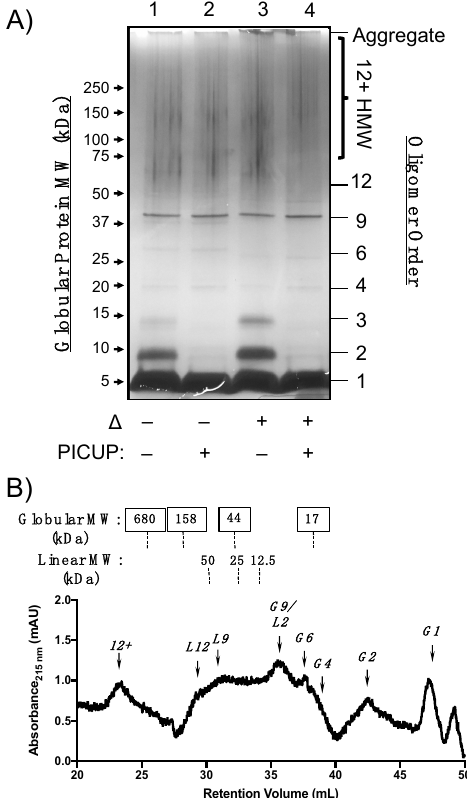
Figure 3. Structural characterization of A β (M1–40) oligomer quaternary structure. ( A ) Silver-stained SDS-PAGE gel of A β (M1–40) oligomers after 24 h incubation at 4 °C in PBS. Lanes 1 and 3 were not subjected to PICUP crosslinking, whereas lanes 2 and 4 contained cross-linked oligomers. Samples in lanes 3 and 4 were thermally denatured ( Δ ) at 95 °C for 5 min prior to SDS-PAGE separation. Globular protein standard molecular weights (left side) and oligomer assembly state (right side) are provided for reference. ( B ) SEC chromatogram of cross-linked A β (M1–40) oligomers separated on tandem gel filtration columns. Approximate molecular weights of globular (top panel, boxed labels) and linear (bottom panel) standards are listed above the chromatogram. The oligomer assembly state corresponding to each peak is listed above an arrow for globular (G1, G2, etc.) and linear (L1, L2, etc.)